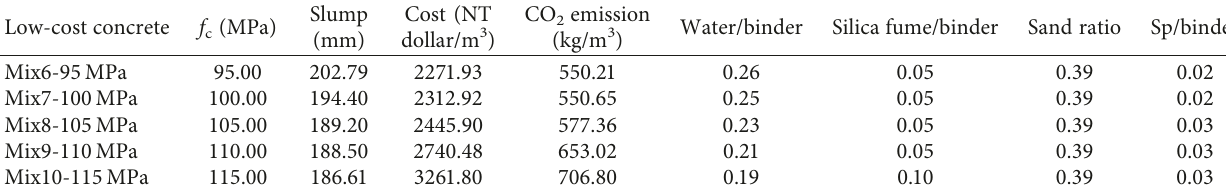
Table 8: Performance of low-cost high-strength